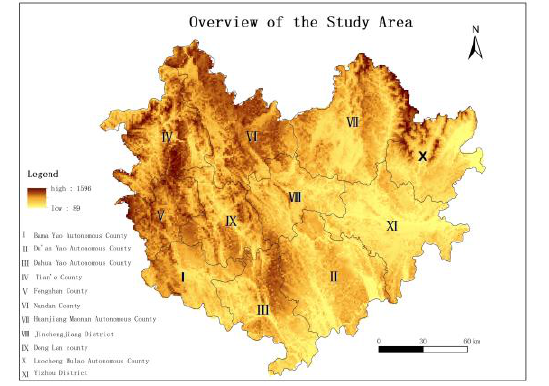
Figure 1. Overview of the study